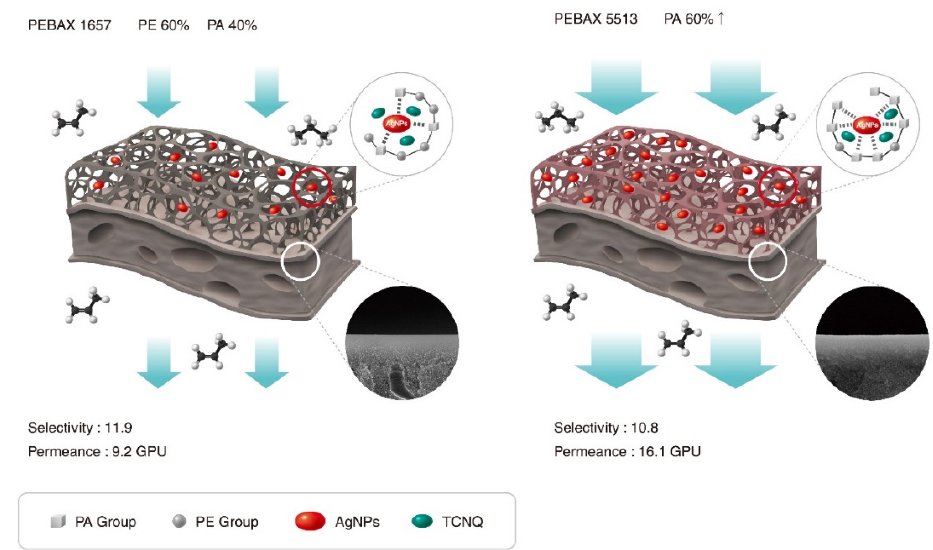
Figure 7. UV-visible absorption spectra of AgNPs in PEBAX-1657/AgNPs/TCNQ and PEBAX- 5513/AgNPs/TCNQ composites.